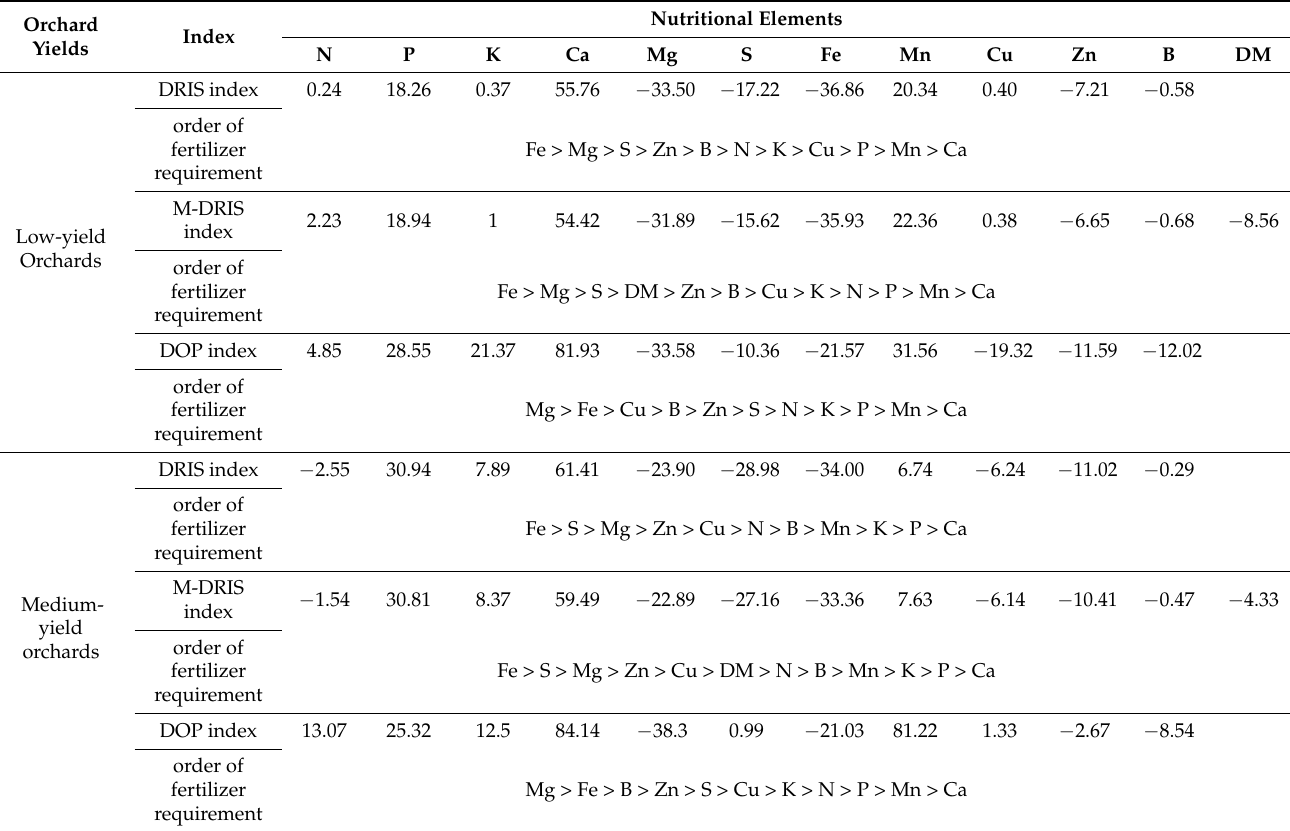
Table 4. The diagnostic index and fertilizer requirement order for Tainong